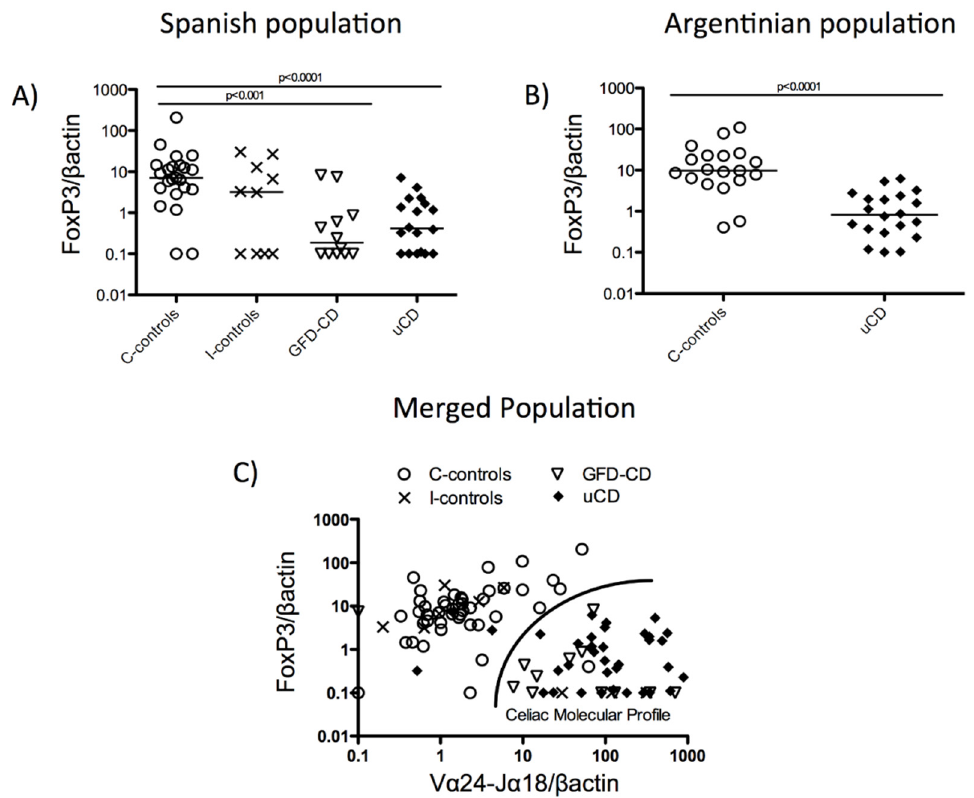
Figure 4. Duodenal mRNA levels of V α 24 ‐ J α 18 and FoxP3 reveal a celiac disease molecular profile. Expression levels of FoxP3 mRNA in duodenal biopsies indicated as the ratio FoxP3/ β actin, in arbitrary units (AU) in untreated Celiac Disease (uCD), Gluten Free Diet ‐ CD patients (GFD ‐ CD), inflamed non ‐ CD controls (I ‐ controls) and non ‐ inflamed non ‐ CD controls (C ‐ controls) in the Spanish population ( A ) and in uCD and C ‐ controls in the Argentinian population ( B ). Statistical differences are shown (two tailed Mann ‐ Whitney U test; Krustall ‐ Wallis test). Horizontal bars are median values. Duodenal molecular profile : Correlation between expression levels of FoxP3 and V α 24 ‐ J α 18 mRNA, in arbitrary units (AU) (C ‐ controls: Spearman r = 0.3495, p value < 0.05; I ‐ controls: Spearman r = − 0.4577, p value = n.s; GFD ‐ CD: Spearman r = − 0.4858, p value < 0.05; uCD: Spearman r = − 0.056, p value = n.s) ( C ).